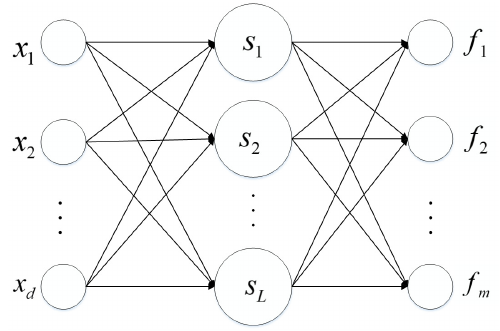
Figure 1. The structure of SCN with a hidden